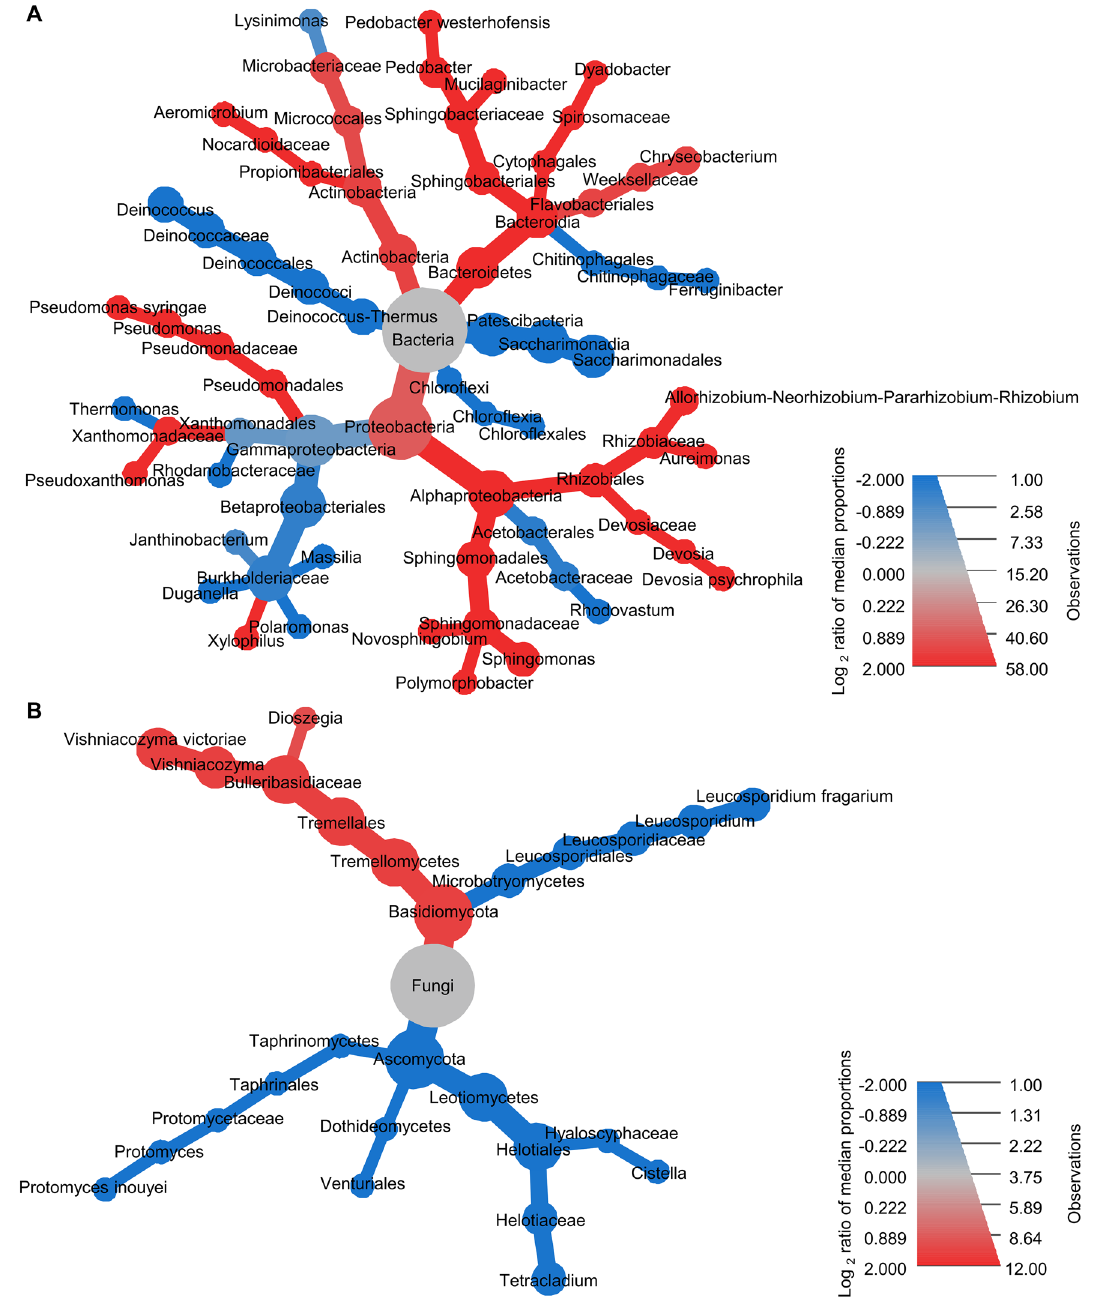
Figure 2. Heat tree of endophytic bacterial ( A ) and fungal ( B ) taxa of Colobanthus quitensis affected by the presence of open-top chambers (OTCs). Amplicon sequence variants (ASVs) affected by the presence of OTCs were identified by indicator taxon analysis with Random Forest models (Supplementary Tables 6 and 8) on C. quitensis leaves collected in open areas (OA samples) or inside open-top chambers (OTC samples) of the Antarctic site 2 (S2) and site 3 (S3). A non-parametric Wilcoxon Rank Sum test was applied to highlight differences in the relative abundances of each taxon in OTC samples compared to OA samples. Taxa with increased and decreased relative abundances in OTC and OA samples are shown respectively in red and blue, according to the colored scale legend of Log 2 -transformed median proportion. For each taxon, the dimension of the node is proportional to the total number of read